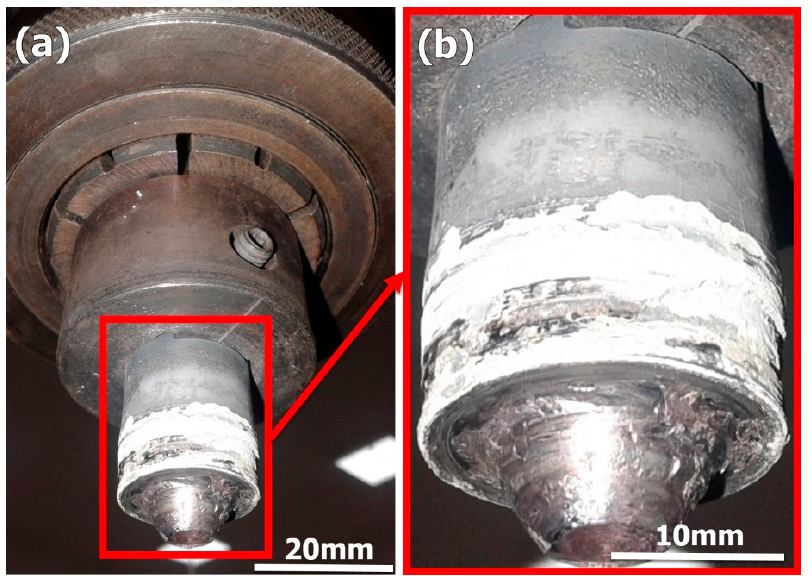
Figure 5. (a) WC FSW tool with the holder arrangement after eight trials of duplex stainless steel welding with the WC tool enlarged in (b).